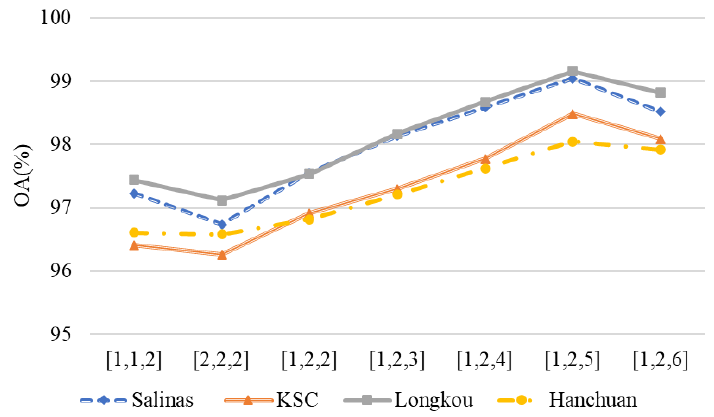
Figure 12. Results of DMLPFFN with different numbers of expansion rates.